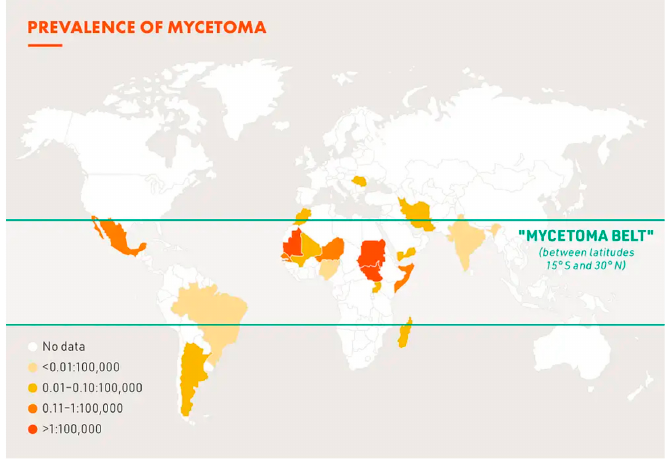
Figure 3. Prevalence of mycetoma (DNDi 2019 adapted from van de Sande WWJ [4]).